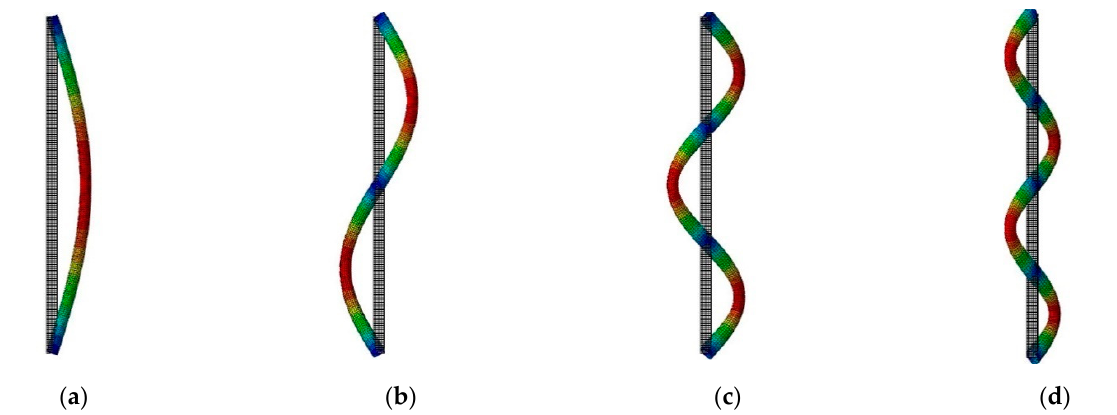
Figure 6. Elastic buckling mode through eigenvalue analysis. ( a) 1st mode; ( b ) 2nd mode; ( c ) 3rd mode; ( d ) 4th mode.